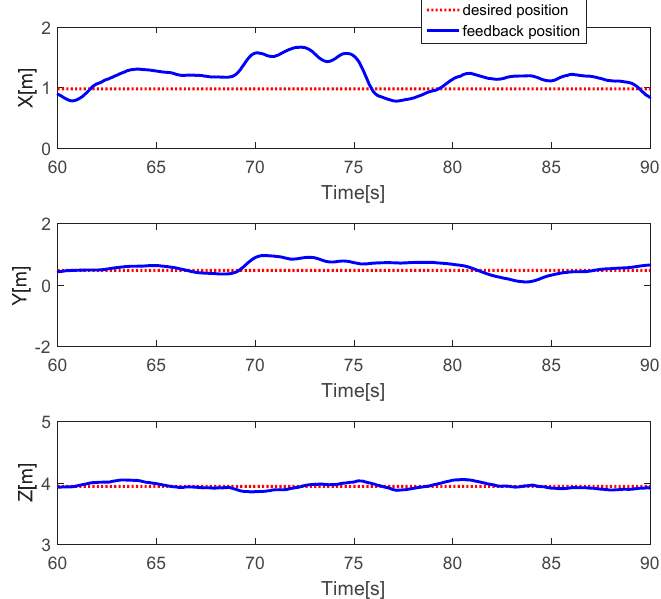
Figure 3. Horizontal and vertical movements of the quadcopter.